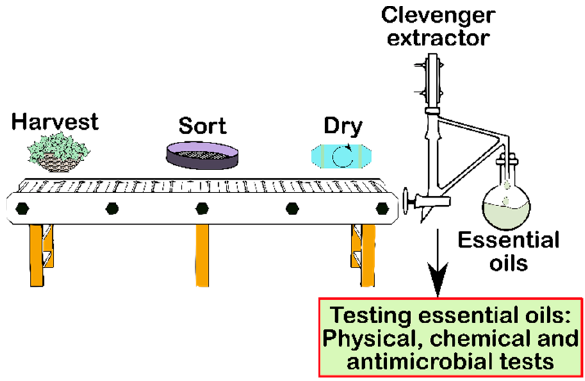
Figure 2. Flow chart for essential oils obtaining.